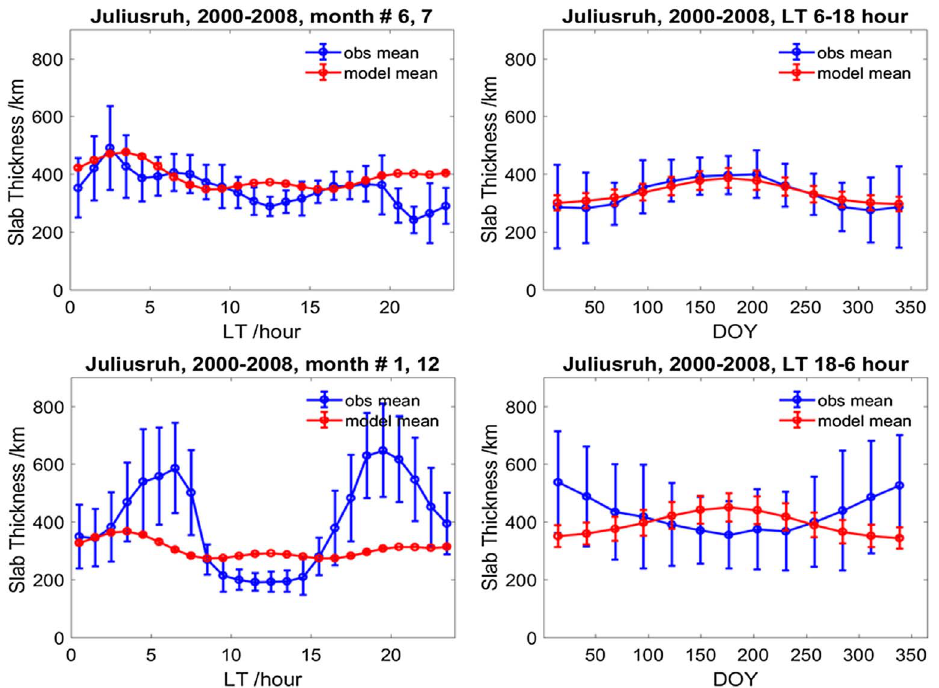
Fig. 10. Diurnal and seasonal variation of the observed and modelled s over Juliusruh for summer (June/July) and winter (December/January) conditions and for day (6 – 18 LT) and nighttime (18 – 6 LT) conditions, respectively.